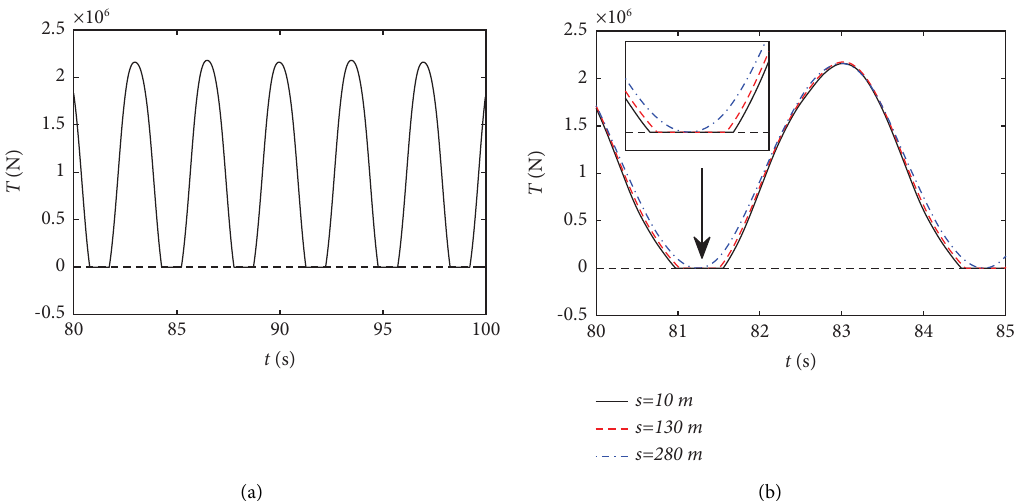
Figure 10: (a) Time history of total tension at 10 m from the anchor point and (b) time history of total tension at diferent positions when the cable is relaxed.